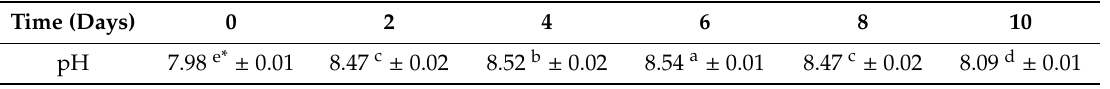
Table 2. The reaction pH of wastewater with algae.